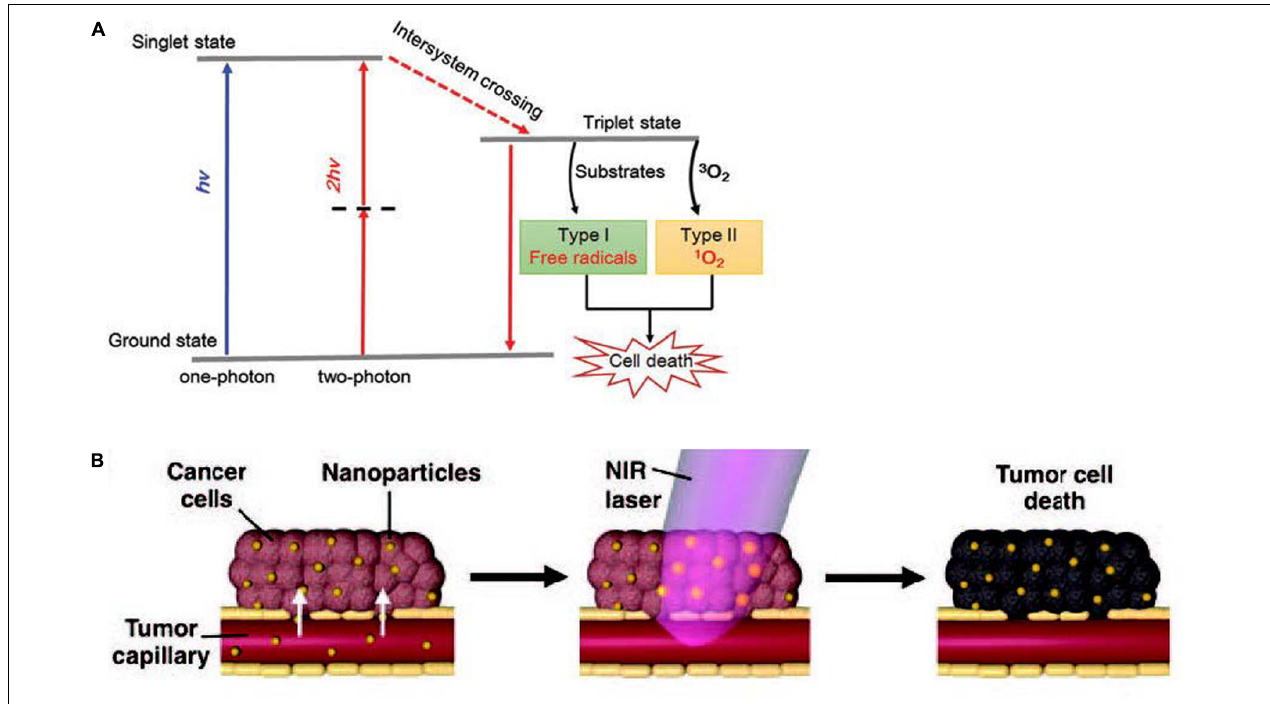
FIGURE 4 | (A) Schematic illustration of type I and type II mechanisms in photodynamic therapy (PDT). Reprinted with permission from Shen et al., 2016, Copyright (2016) Royal Society of Chemistry. (B) Schematics demonstrating photothermal therapy. Reprinted with permission from Riley and Day (2017), Copyright (2017) John Wiley and